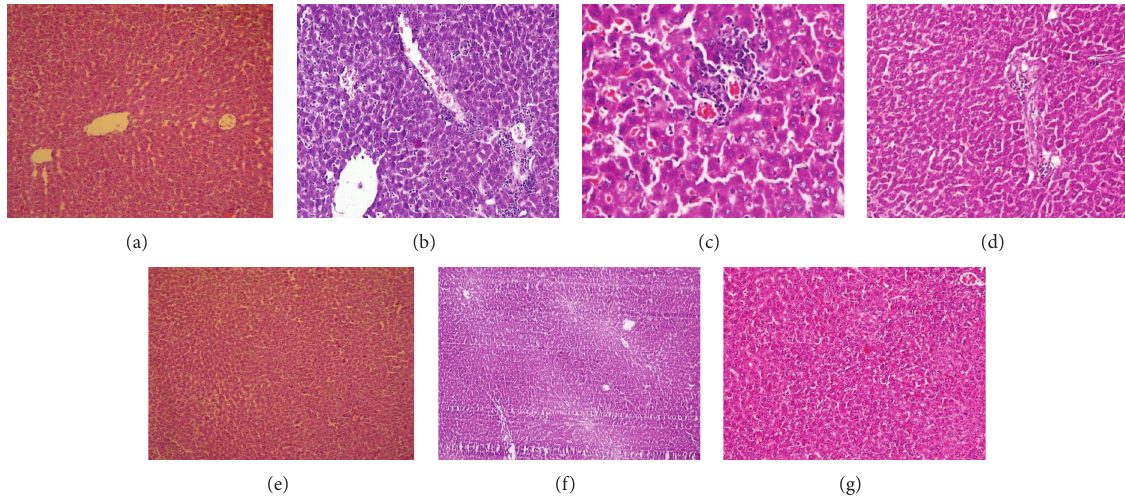
Figure 5: Representative photomicrographs of hematoxylin-eosin stained rat liver sections. (a) Normal rat liver (100x); ((b), (c)) liver section from rat administered 10–14g/kg of body weight of 35% alcohol orally for 12 weeks showing vacuolar degeneration, microvesicular fatty change, focal collection of lymphocytes, and vascular congestion (200x, 400x), respectively; (d) photomicrograph of alcohol administered cosupplemented with free probiotic group showing normal histology with little hyperplasia of Kupffer cells (100x); (e) photomicrograph of alcohol administered cosupplemented with encapsulated probiotic group showing normal histology (100x); (f) photomicrograph of free probiotic per se group showing normal histology (100x); (g) encapsulated probiotic per se group showing normal histology (100x).